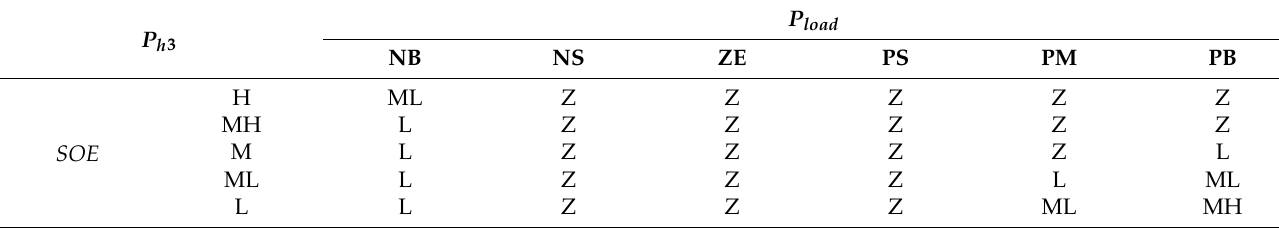
Table 5. Fuzzy rule for the high temperature